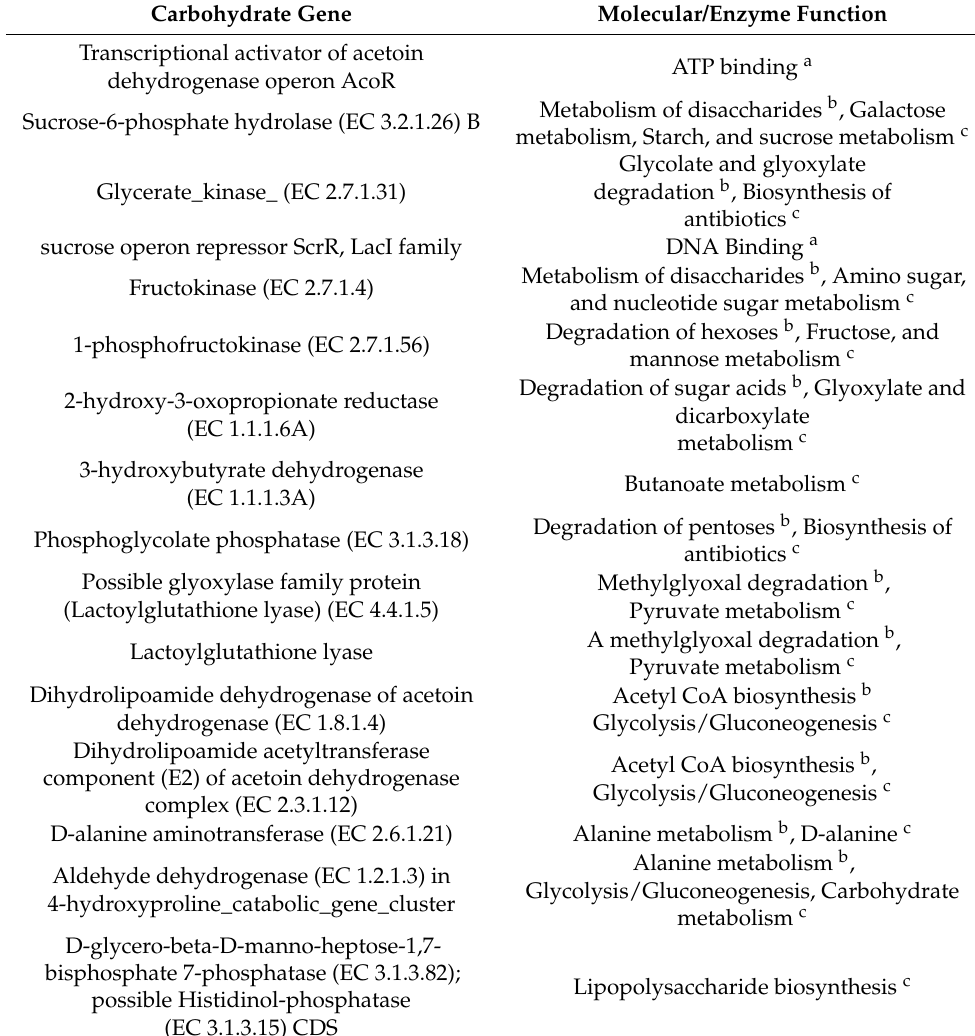
Table 4. Carbohydrate utilization-related genes that are present in B. cereus strain (Bc57) ST 2103. Carbohydrate Gene Molecular/Enzyme Function Transcriptional activator of acetoin ATP binding a dehydrogenase operon AcoR Metabolism of disaccharides b , Galactose Sucrose-6-phosphate hydrolase (EC 3.2.1.26) B metabolism, Starch, and sucrose metabolism c Glycolate and glyoxylate Glycerate_kinase_ (EC 2.7.1.31) degradation b , Biosynthesis of antibiotics c DNA Binding